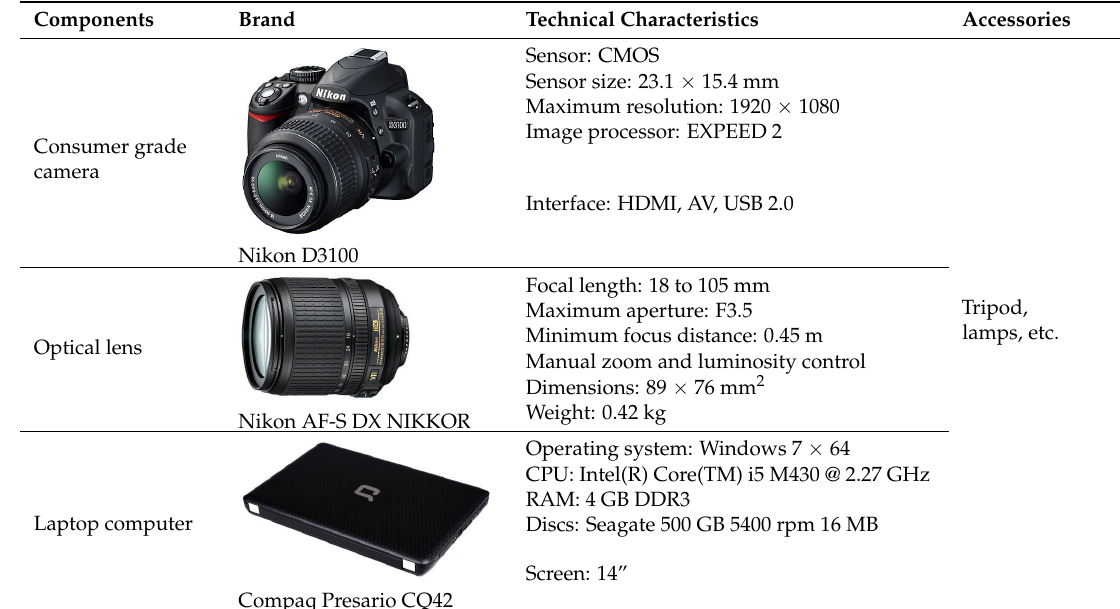
Table 4. Hardware components of proposed vision-based sensor.